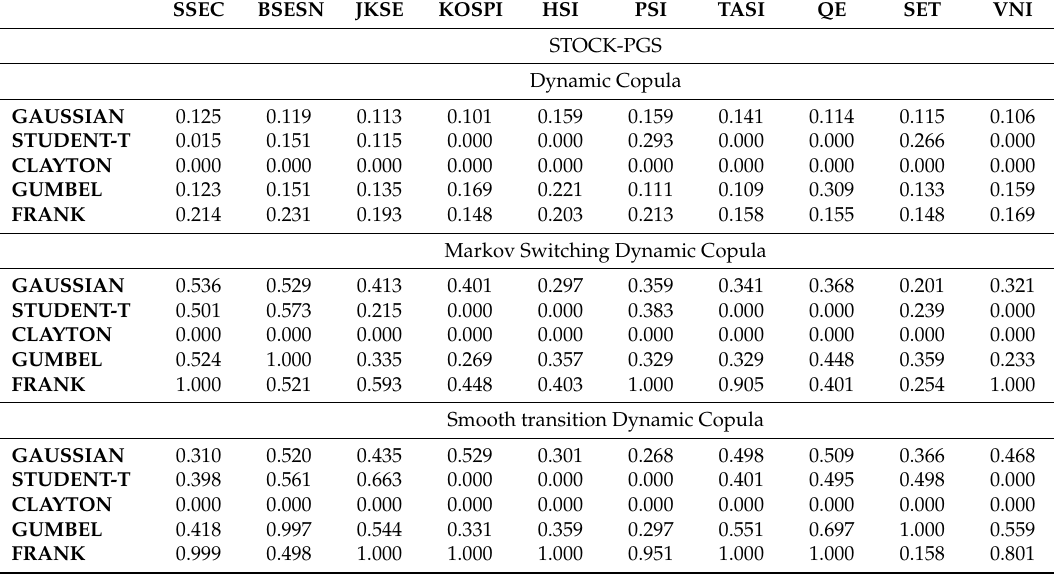
Table 12. The out-of-sample evaluation of forecasts of correlation between positive gold shock and stock volatilities.